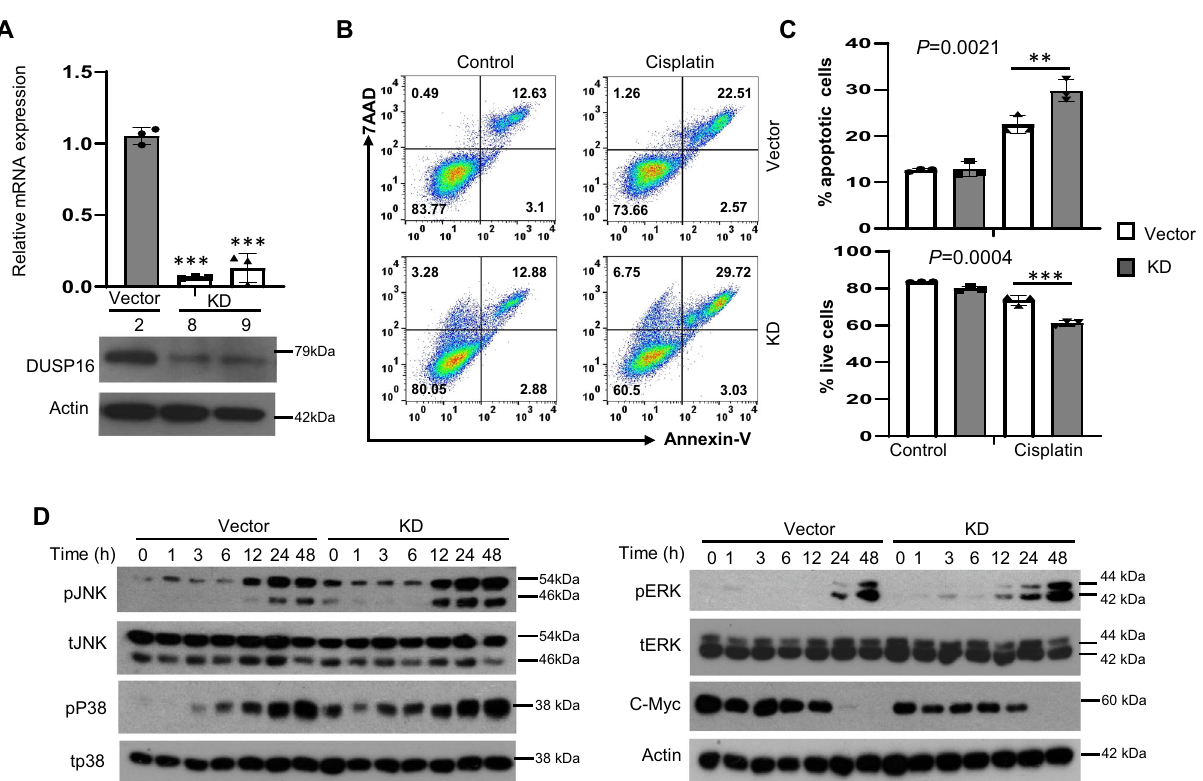
Fig. 6 DUSP16 knockdown enhances apoptosis in C666-1 cells in response to cisplatin. C666-1 cells were transfected with DUSP16 CRISPR/Cas9 constructs to knockdown DUSP16 expression. A Bar chart shows the mRNA expression in vector and DUSP16 construct transfected cells with mean values ± SEM, n = 3 biologically independent samples. Statistical analysis was performed using two-tailed unpaired t -test. Protein levels of DUSP16 were quanti fi ed by immunoblotting. *** P < 0.0001. B Apoptosis of control and DUSP16 knockdown (KD) cells after cisplatin treatment was measured by AnnexinV/7AAD staining and fl ow cytometry. C Bar charts show the percentage of apoptotic and surviving (unstained) cells with mean values ± SEM, n = 3 biologically independent samples. Statistical analysis was performed using two-tailed unpaired t -test. The data are representative of three experiments with similar results. D Western blot analysis of the pJNK, pP38, pERK, their total protein levels, and c-Myc in control or DUSP16-KD C666-1 cells was carried out after cisplatin treatment. The data are representative of three experiments with similar results. Source data are provided as a Source data fi